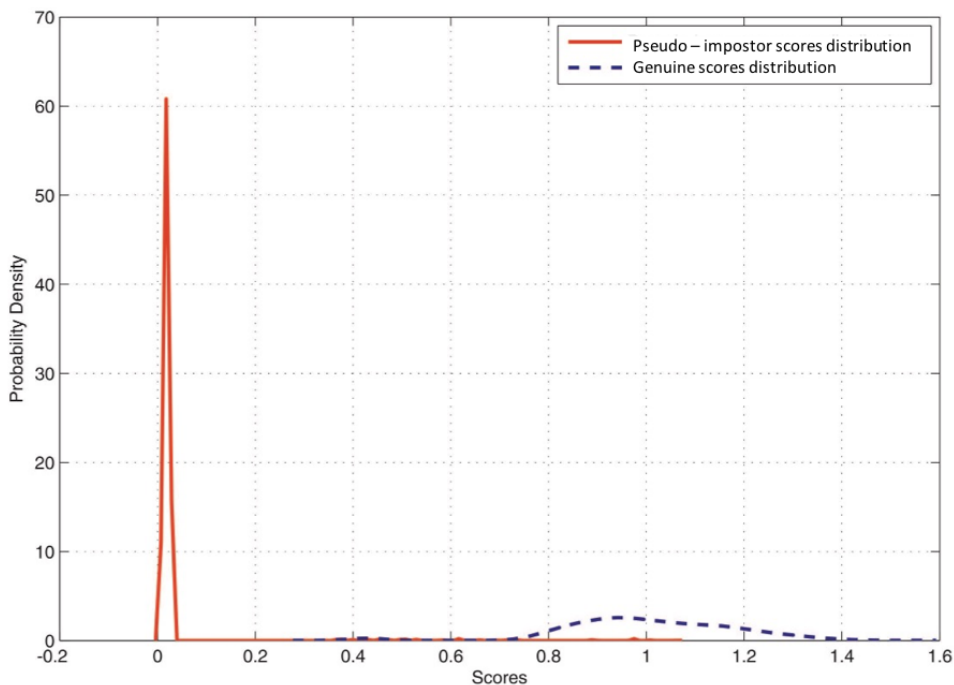
Figure 11. The matching distribution of genuine and pseudo-impostor